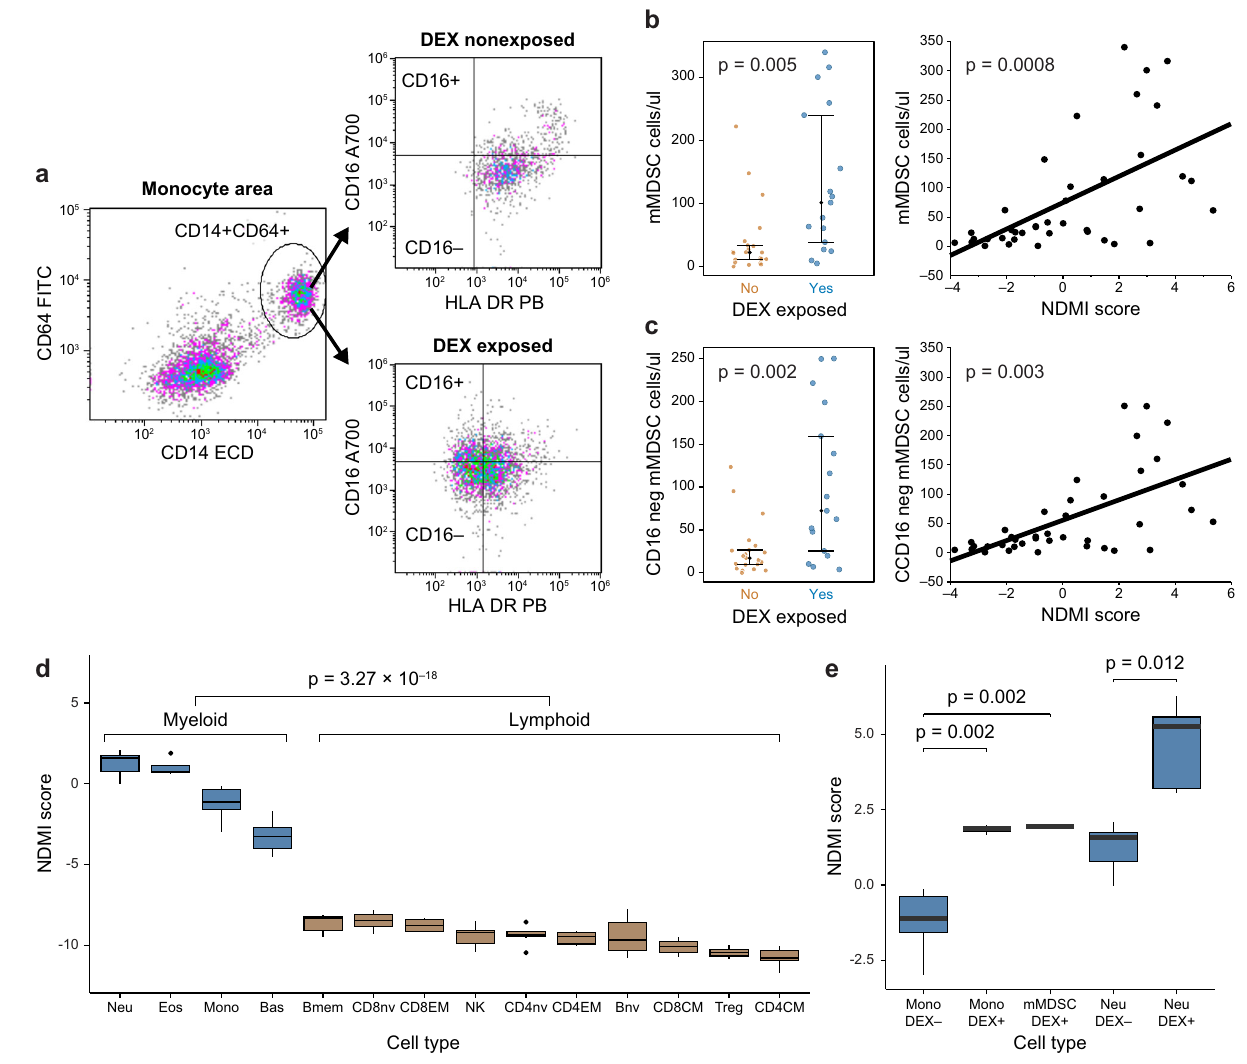
Fig. 6 | NDMI scores in isolated DEX exposed and non-exposed myeloid and lymphoid blood immune cell subtypes. a FCM dot plots showing the gating procedure to quantify HLA-DR − CD14 + CD16 − monocytes (putative mMDSCs). b Elevated total mMDSCconcentrations inglioma subjects exposed to DEX( n =38 (19 DEX exposed and 19 non-DEX exposed))and correlation of total mMDSCs with NDMIscores. c Elevatedblood concentrationsofCD16 − mMDSCingliomasubjects exposedtoDEX( n =38(19DEXexposedand19non-DEXexposed))andcorrelation ofCD16 − mMDSCconcentrationswithNDMIscores.For b , c ; p valuesfordifference